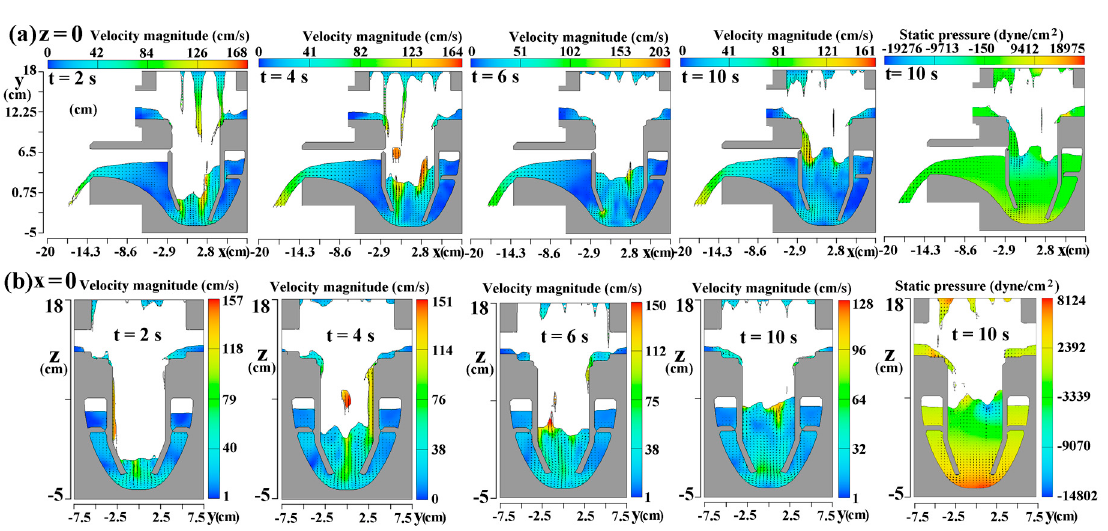
Figure 4. Distributions of velocity and static-pressure at t = 2, 4, 6, 10 s on: ( a ) z = 0; and ( b ) x = 0 planes for test gully with beveled nozzle flow with Q floor = 0.6